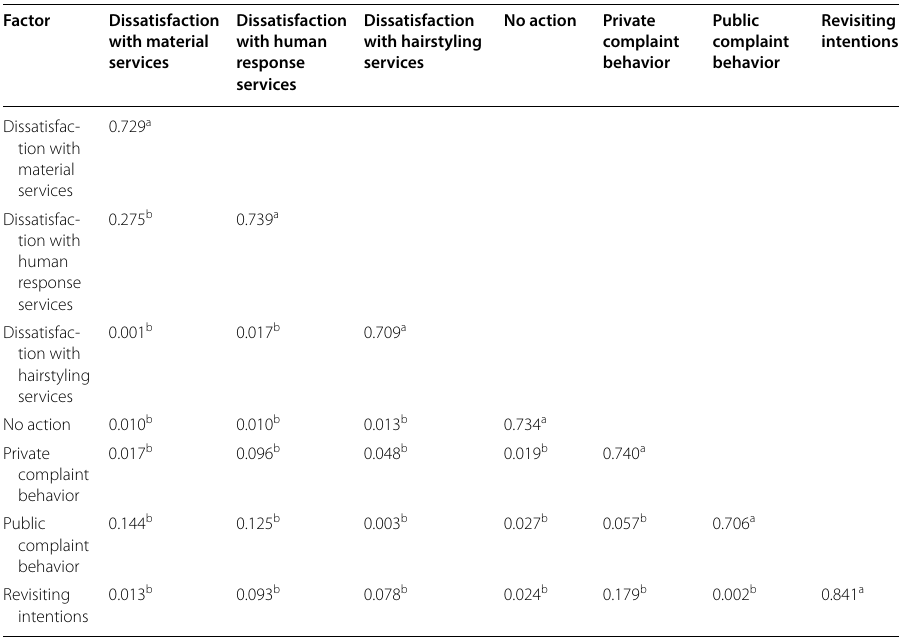
a Average variance extracted of variables (AVE)